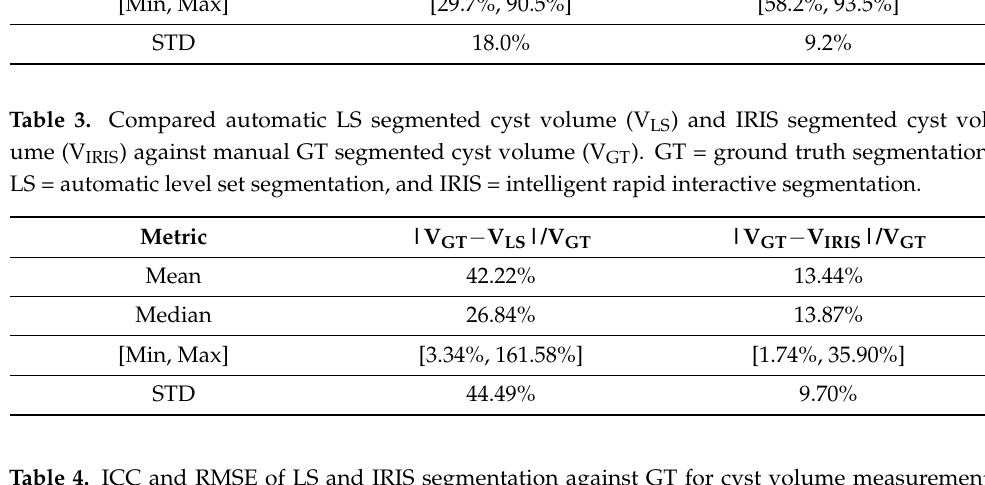
Table 4. ICC and RMSE of LS and IRIS segmentation against GT for cyst volume measurement. GT = ground truth segmentation, LS = automatic level set segmentation, IRIS = intelligent rapid in- teractive segmentation, ICC = intraclass correlation coefficient, and RMSE = root mean squared error. Metric LS IRIS ICC 98.91%